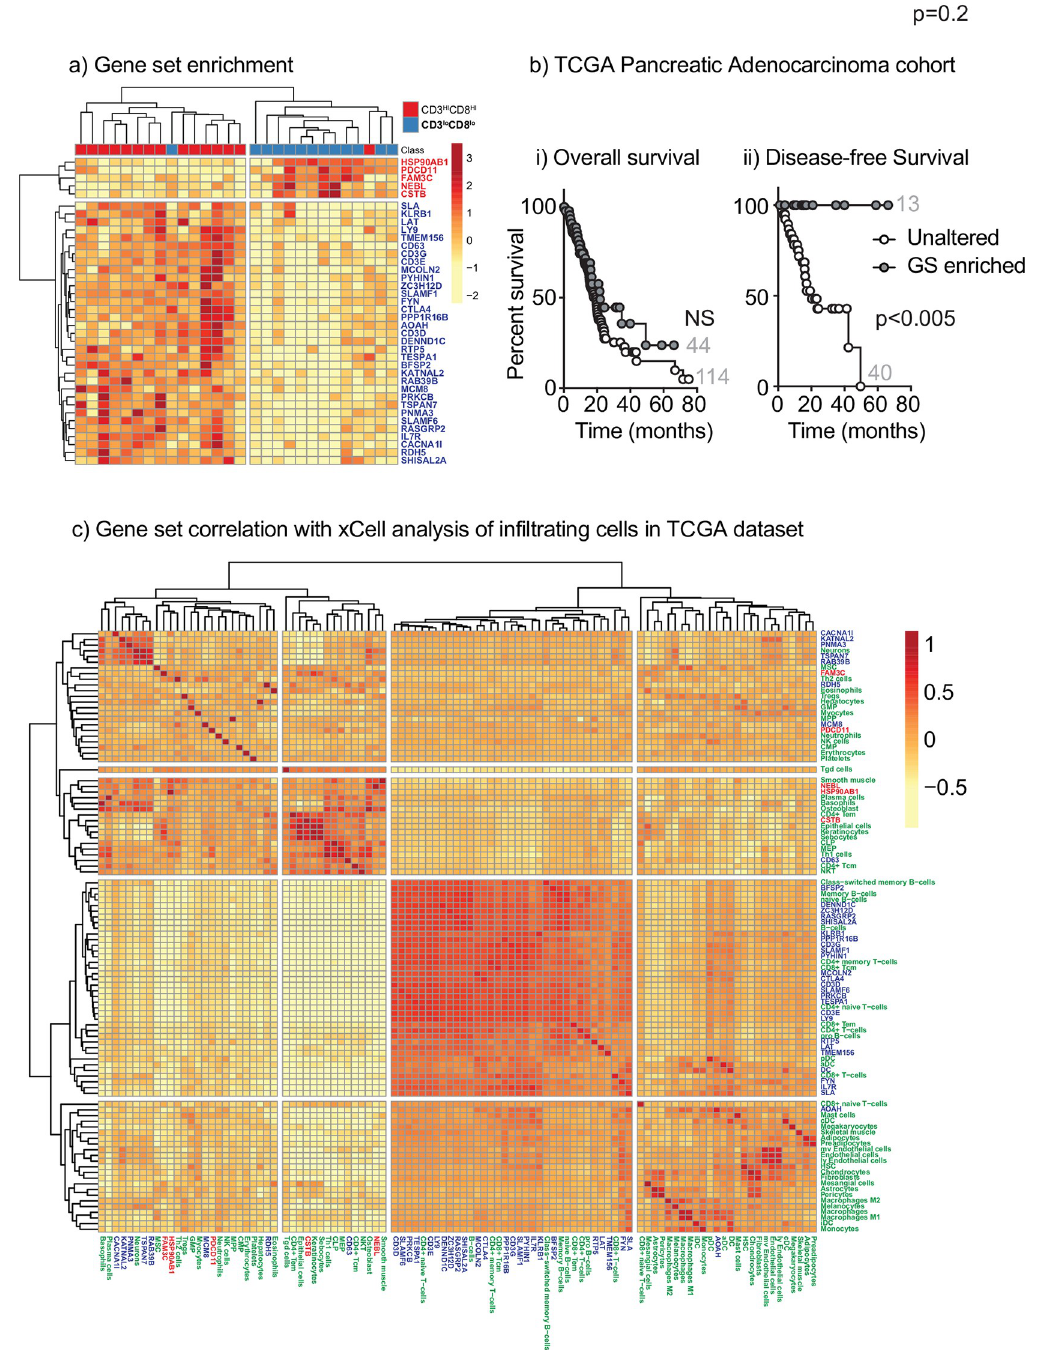
Fig 4. Class comparison of TPM counts on patients with high T cell infiltrate and validation on TCGA cohort. a) Class comparison of TPM counts was performed on patients with high CD3 + and high CD8 + infiltrates, as compared to patients with low CD3 + and low CD8 + infiltrates using the cutoffs applied in Fig 1. Graph shows the clustering of 38 significant genes (p < 0.001). Genes enriched in poorly infiltrated tumors are highlighted in bold. b) The genes enriched in highly infiltrated tumors were tested using the TCGA PanCan Pancreatic Adenocarcinoma cohort to identify patients with enriched RNA expression of these genes. Graphs show i) overall survival and ii) disease-free survival for patients in each group. The number of patients in each group is shown. c) Correlation matrix of the expression of the genes listed in a), and xCELL calculated cell infiltration for the TCGA PanCan Pancreatic Adenocarcinoma cohort. Rows are centered; no scaling is applied to rows. Both rows and columns are clustered using Manhattan distance and average linkage. 102 rows, 102 columns. Genes are highlighted in Blue where positively correlated and Red when negatively correlated. Cell types are highlighted in Green.